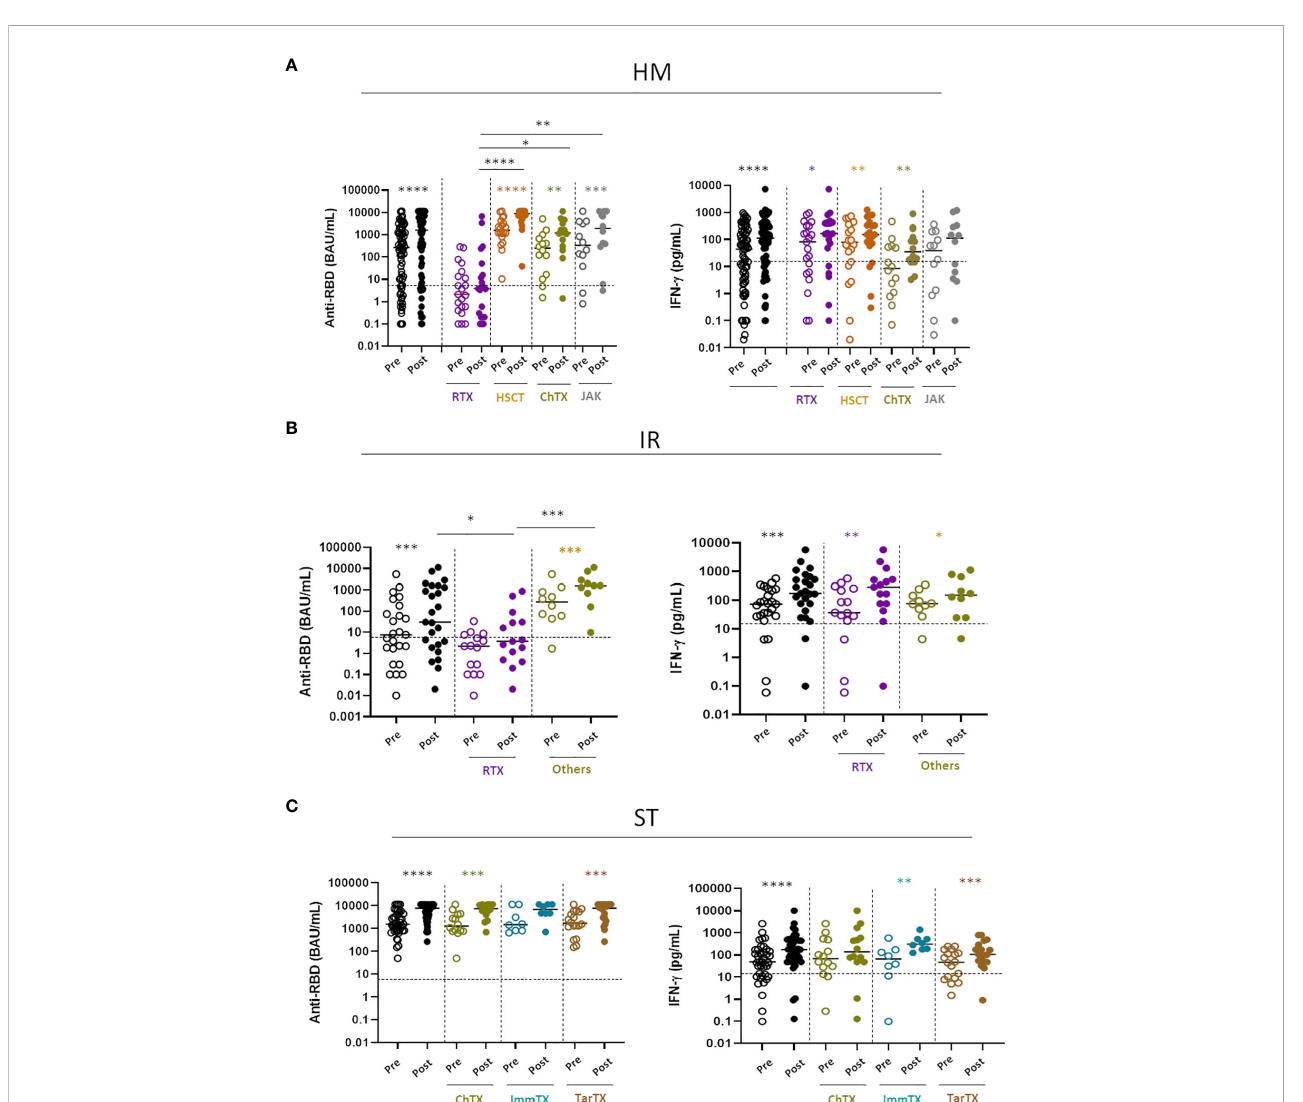
FIGURE 3 Impact of different treatments on humoral and T-cell response (A) SARS-CoV-2 speci fi c anti-RBD Abs and T cell response before (pre) and after (post) the fourth dose of mRNA vaccine were compared in HM patients receiving different treatments: Rituximab (RTX), hematopoietic stem cell transplantation (HSCT), Chemotherapy (ChTX), JAK inhibitors (JAK) or others. (B) SARS-CoV-2 speci fi c anti-RBD Abs and T cell response before (pre) and after (post) the fourth dose were compared in IR patients receiving different treatments: Rituximab (RTX) and other (methotrexate, mycophenolate mofetil, and azathioprine). (C) SARS-CoV-2 speci fi c anti-RBD Abs and T cell response before (pre) and after (post) the fourth dose of mRNA vaccine were compared in ST patients receiving different treatments: Chemotherapy (ChTX), Immunotherapy (ImmTX) and Target therapy (TarTX). The median and IQR are described in Supplementary material. Differences between anti-RBD or T cells response level before and after vaccination within the same group was evaluated by Wilcoxon paired test, while differences across groups were evaluated by Kruskal-Wallis. ****P<0.0001, ***P<0.001, **P<0.01, *P<0.05. HM, hematological malignancies; IR, immune-rheumatological diseases; ST, solid